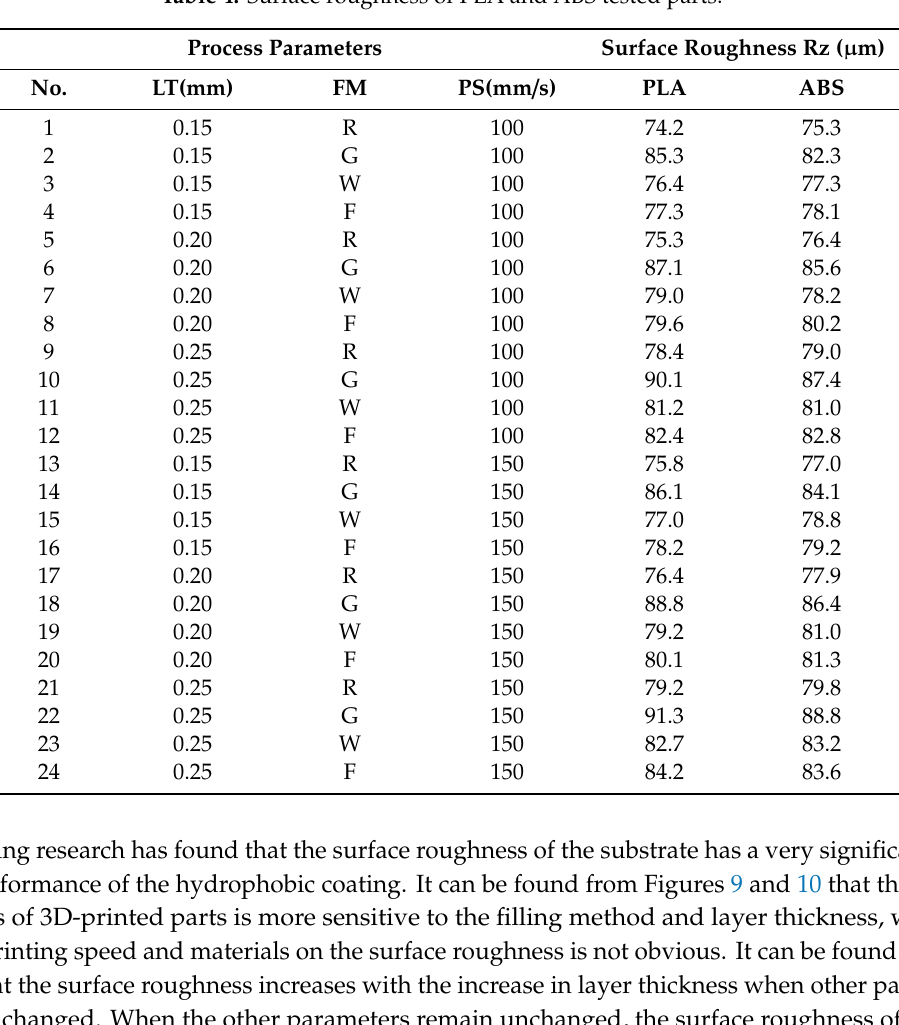
Table 4. Surface roughness of PLA and ABS tested parts.